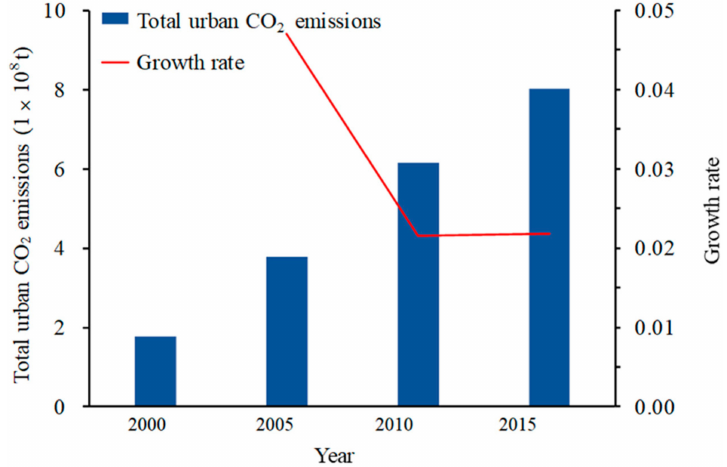
Figure 4. The total urban CO 2 emissions and corresponding growth rate in China from 2000 to 2015.